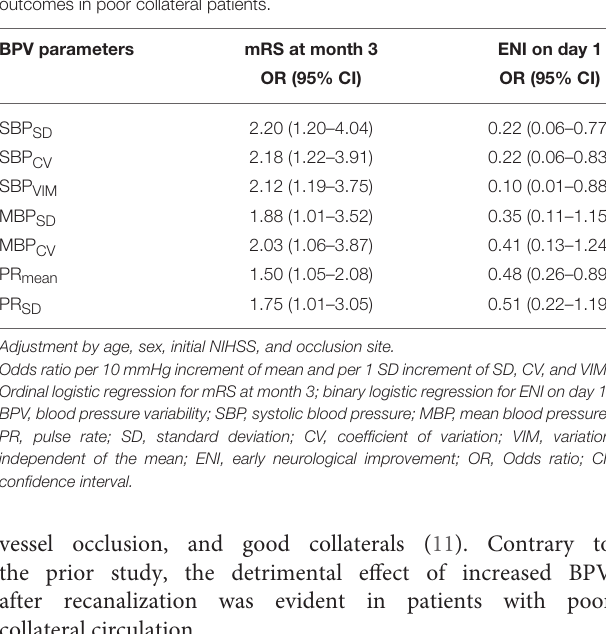
TABLE 4 | Association of blood pressure variability parameters with functional outcomes in poor collateral